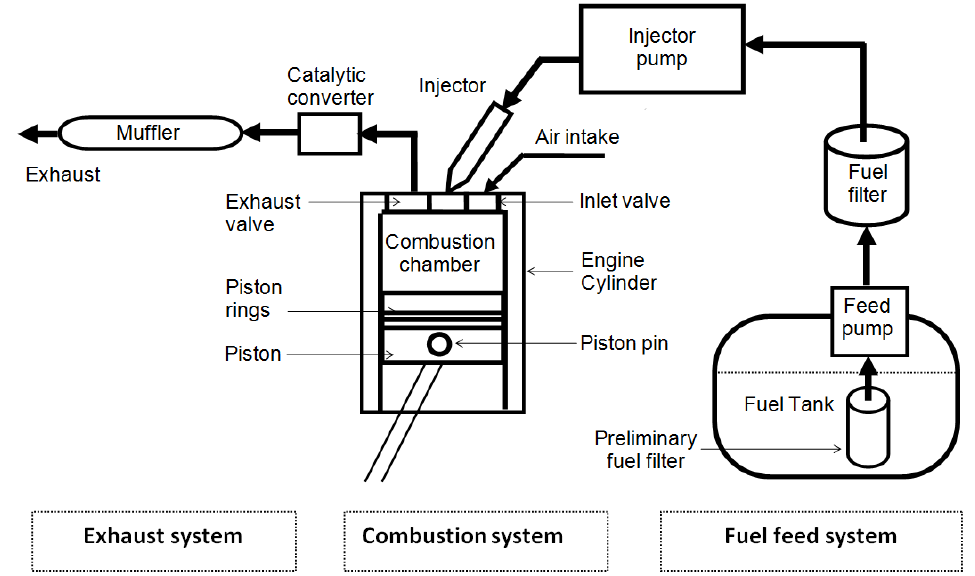
Figure 7. Schematic diagram of a typical diesel engine fuel system [12].